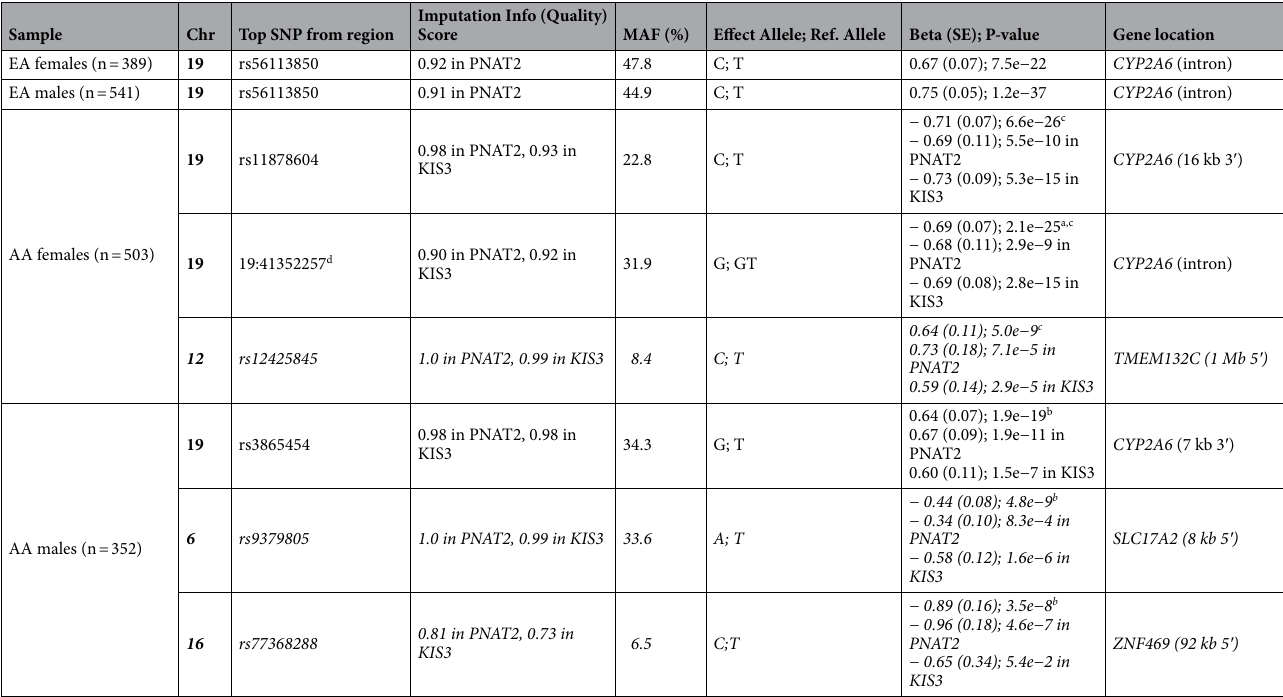
Table 1. Independent variants from each genome-wide significant locus in EA and AA smokers. Novel loci associated with the nicotine metabolite ratio (rank-transformed for analysis) were found in AA females and AA males and are indicated in italics. EA European American, AA African American, Chr chromosome, info info (i.e. quality) score from imputation, MAF minor allele frequency, SE standard error. Conditional analysis was used to determine the number of independent signals for each chromosome containing genome-wide significant variants. a After conditioning on rs11878604, the beta (SE) for 19:41352257 was − 0.45 (0.08), and the P-value was 8.3e−9. b Beta, SE, and P-value is reported for the meta-analyzed PNAT2 and KIS3 AA males. c Beta, SE, and P-value is reported for the meta-analyzed PNAT2 and KIS3 AA females. d No rsID is available for this variant in